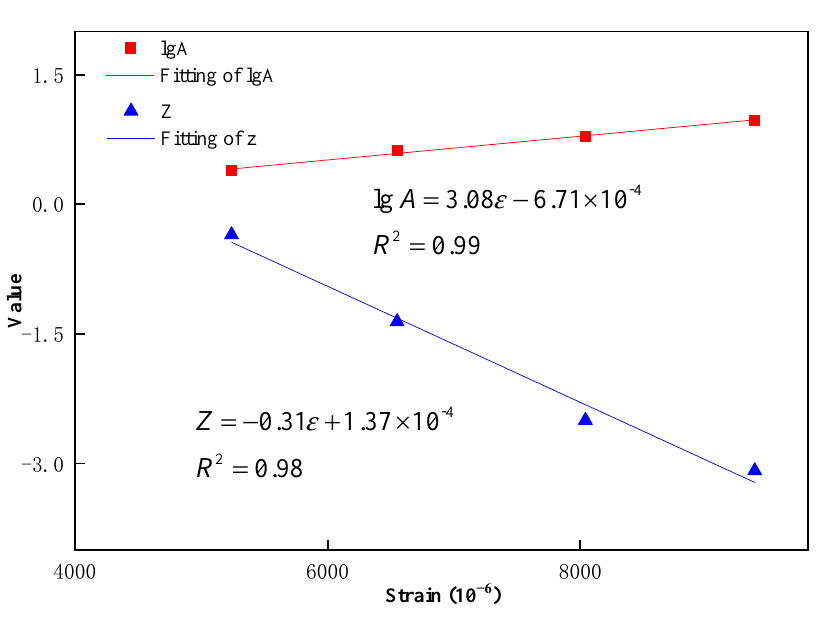
Figure 15. Fitting results of parameters.